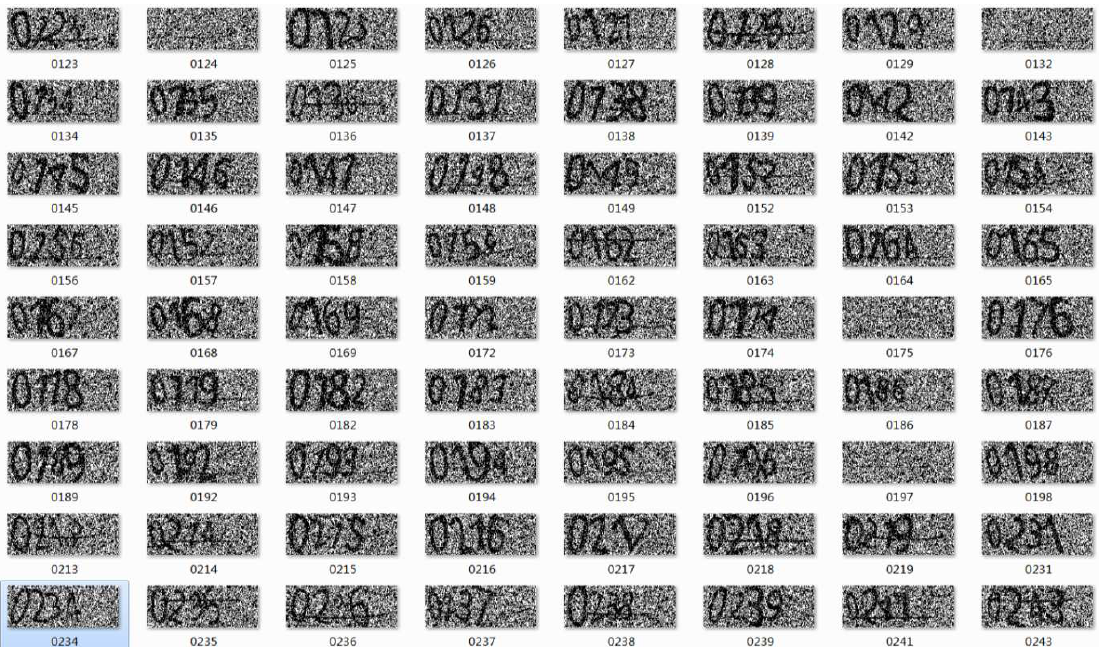
Figure 6. Some captchas generated by the proposed method.